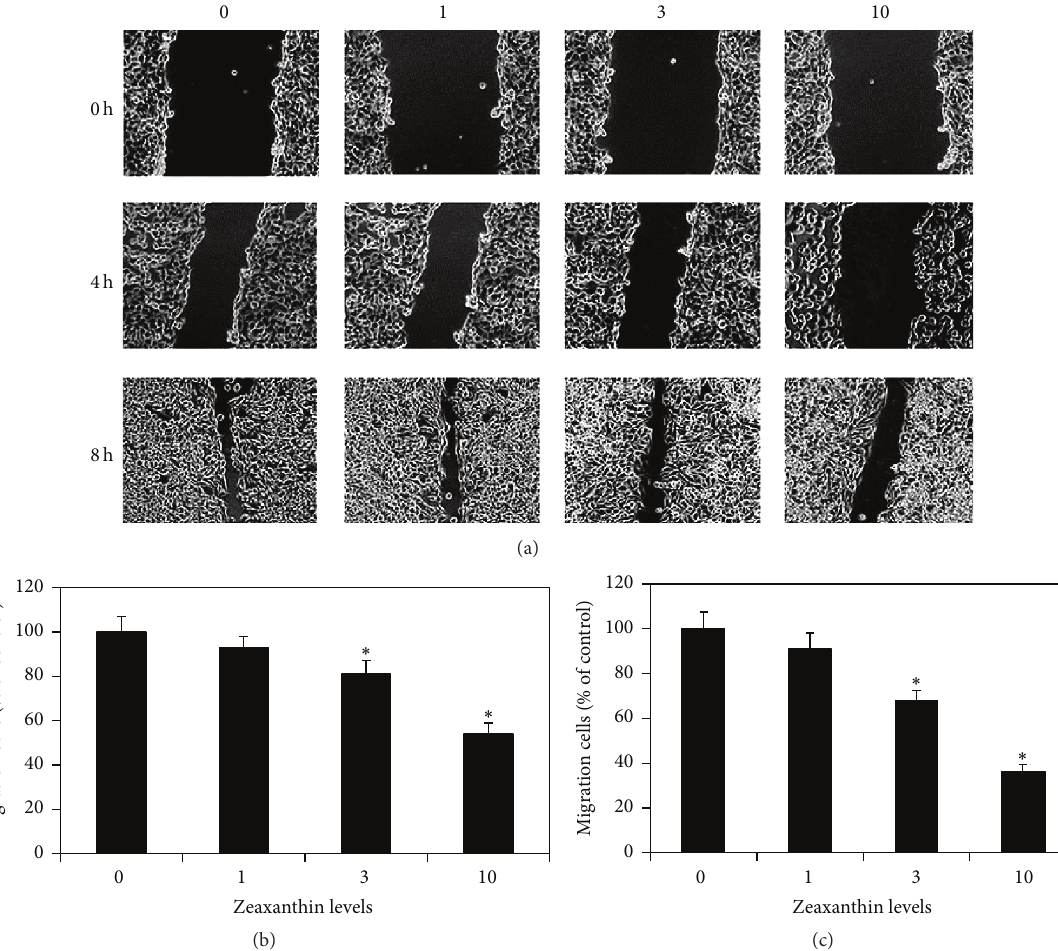
Figure 2: Zeaxanthin inhibits wound closure in cultured UM cells. Cultured human UM cells (C918) were seeded into 12-well plates, scratched, and treated with zeaxanthin (0, 1, 3, and 10 𝜇 M) for 0, 4, and 8h. Phase-contrast pictures of the wounds were taken for the comparison of wound closing process between cells treated with different levels of zeaxanthin at different periods (a). Cells migrating from the leading edge were counted at 4 h (b) and 8h (c) and expressed as the percentage of the controls (cells cultured without zeaxanthin). After incubation for 4h and 8h, migrating cells in cultures treated with zeaxanthin at 3 and 10 𝜇 M were significantly less than those from the controls (without zeaxanthin) ( 𝑃 < 0.05 ). Please see the text (Section 3.2) for the original data and the percentages of the controls (mean ± SD) of each group at different time